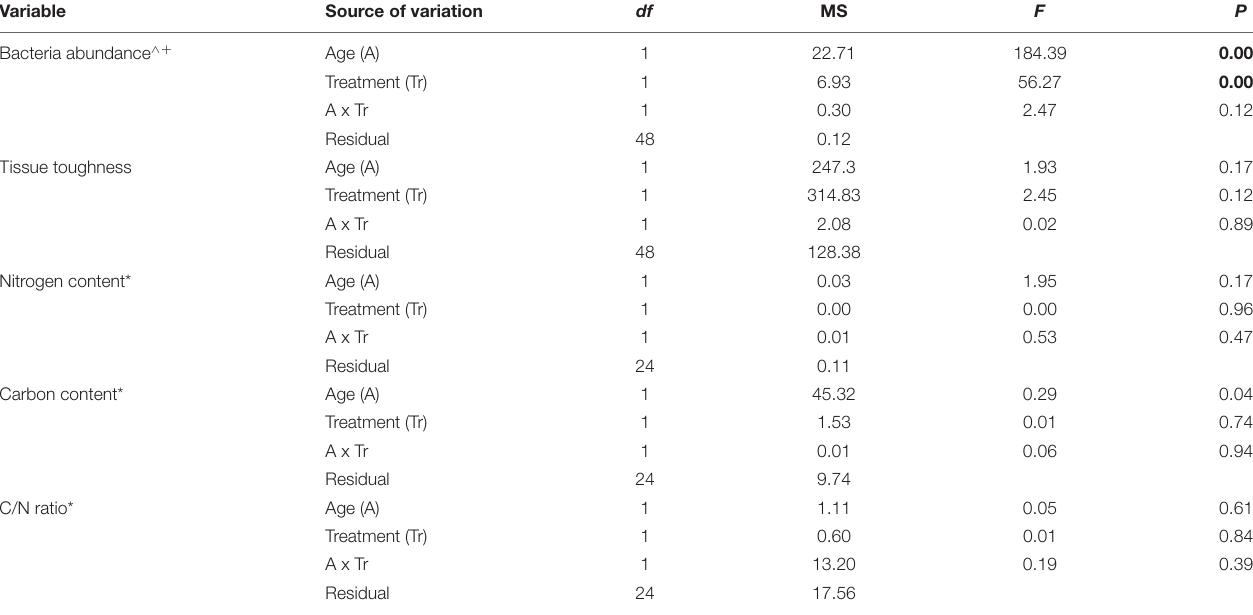
TABLE 1 | Results of two-way ANOVA examining the effects of wrack type (Fresh kelp and 2 weeks Aged kelp) and treatment (Control and Antibiotic treatment) on heterotrophic bacterial abundances, and tissue toughness, nitrogen content (%N), carbon content (%C), and C/N ratio of kelp tissue.